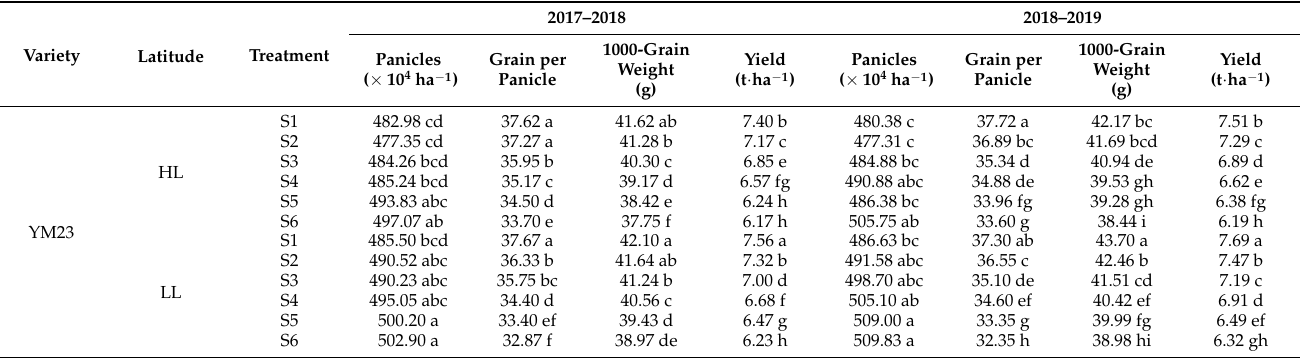
Table 5. Effects of different temperature and radiation on wheat